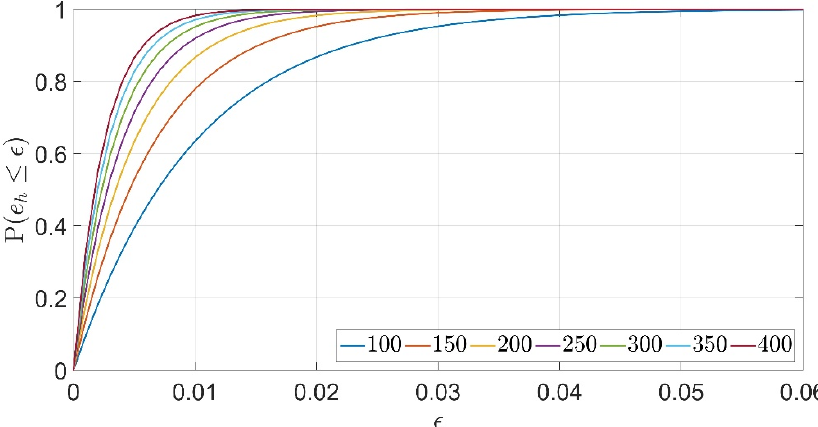
Figure 5. Cumulative distribution function of 𝑒 (cid:3035) when no information is not known a priori ‐ worst ∈ ∈ {100,150,200,250,300,350,400}. case scenario—for N r case scenario ‐ for 𝑁 (cid:3045) h (cid:3283)